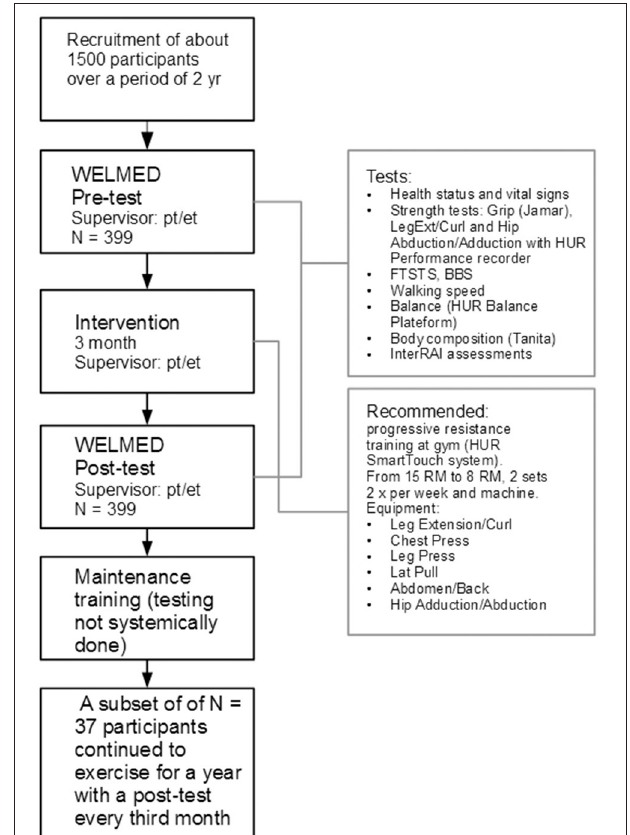
FIGURE 1 | The Gym Tonic process and the data collection. Thousand five hundred participants were registered. The sites were asked to deliver data on those who had properly completed the 12-week training and the pre and post assessments ( N = 399). Welmed stands for a test protocol summerized by the upper right box. FTSTS, five times sit to stand; BBS, Berg balance scale; pt, physiotherapist; et, exercise